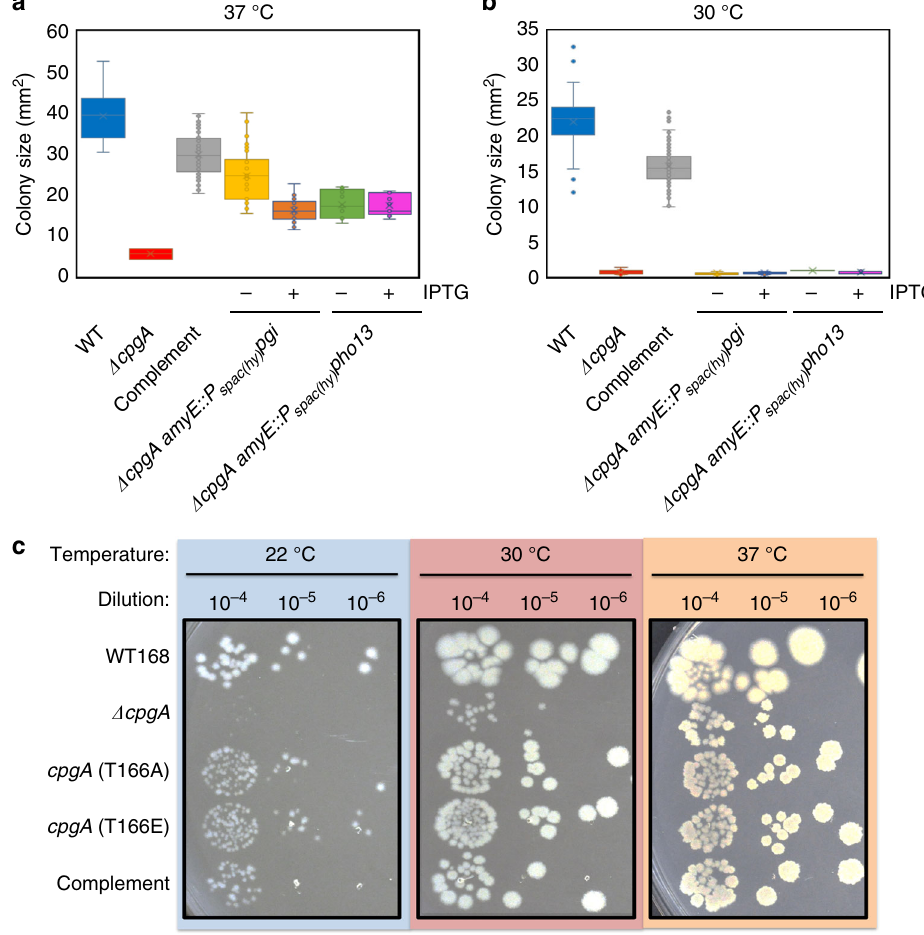
Fig. 6 CpgA has separable functions in ribosome assembly and metabolite proofreading. Box plot of colony area ( n ≥ 45) determined with ImageJ software for various strains (WT in blue, Δ cpgA in red, complement in gray, Δ cpgA expressing Pgi with (orange) and without IPTG (yellow), and Δ cpgA expressing Pho13 with (pink) and without IPTG (green) plated at 37 °C ( a ) and at 30 °C ( b ) for 40 h. c All strains were grown to OD 600 of ~0.4, serially diluted, and spotted onto LB agar plates with incubation at 22 °C, 30 °C, or 37 °C for 40 h. Boxplot depicting centerline represents the second quartile (median) and the bottom and top of the box are the fi rst and third quartiles, respectively and the X inside the box is the mean. Whiskers extend 1.0 quartile range. Outliers are shown as single